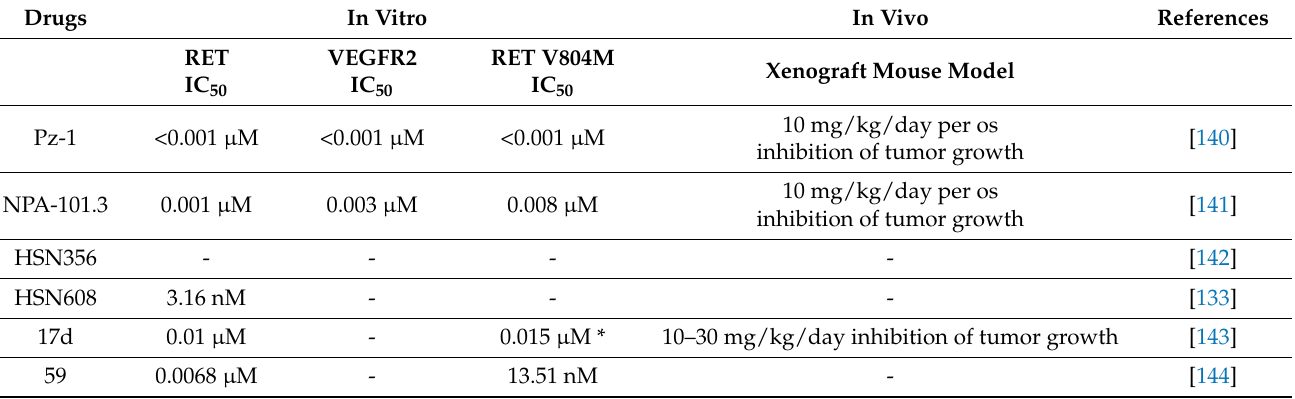
Table 4. Candidates in preclinical